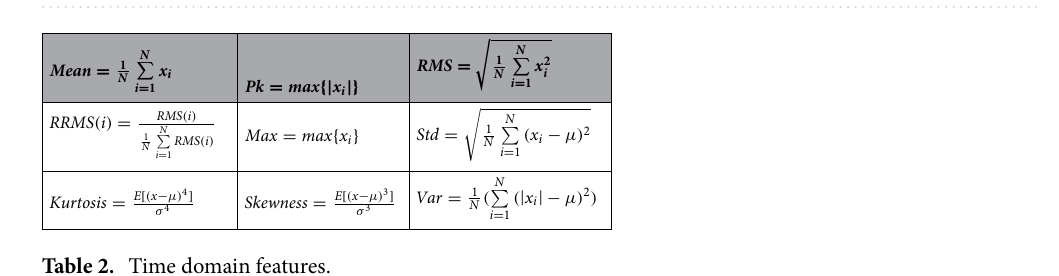
Figure 7. Plots of RMS vs. RRMS ( a ) RMS; ( b ) RRMS.